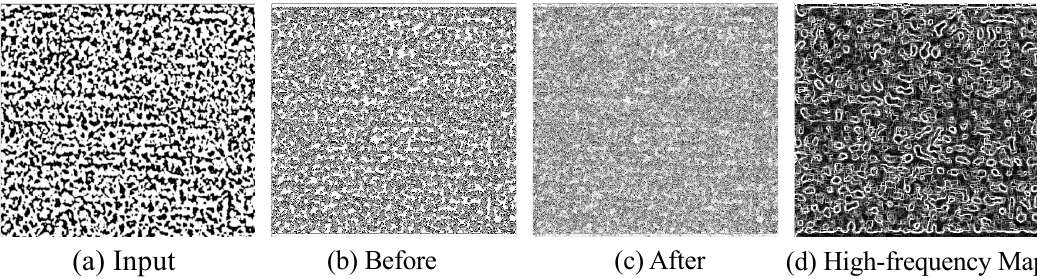
Figure 8. The visual comparison of the segmentation results on dataset SPMID.